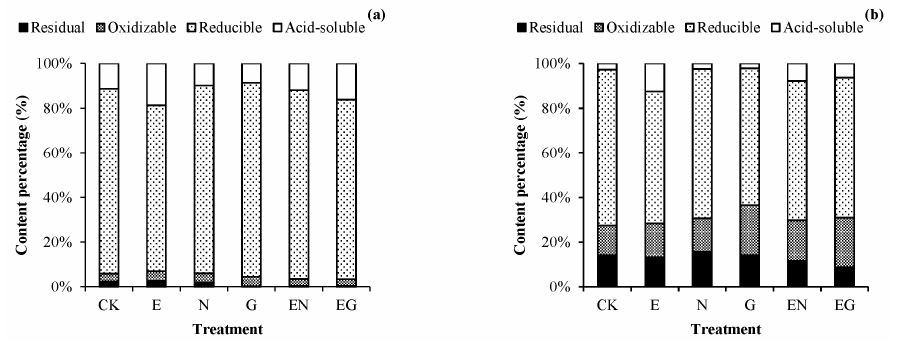
Figure 4. Effects of different treatments on the morphological distribution of Pb in ( a ) rhizosphere soil and ( b ) non-rhizosphere